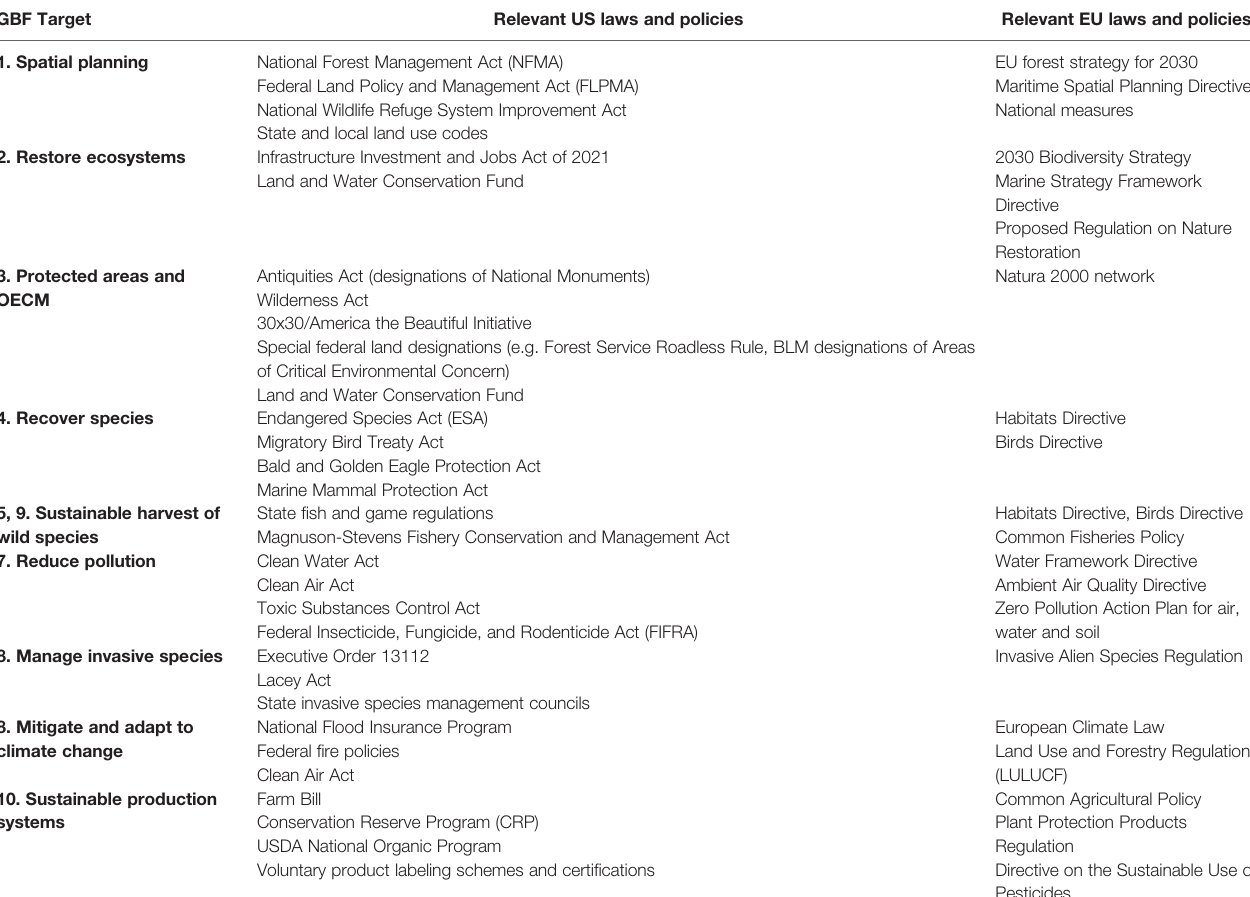
TheGBFincludesadditional targetsdesignedtoaddressindirectdriversofbiodiversitylossandtheadditionalGBFgoals(goalsB,C,andD)whicharenotdirectlyfocusedonbiodiversity